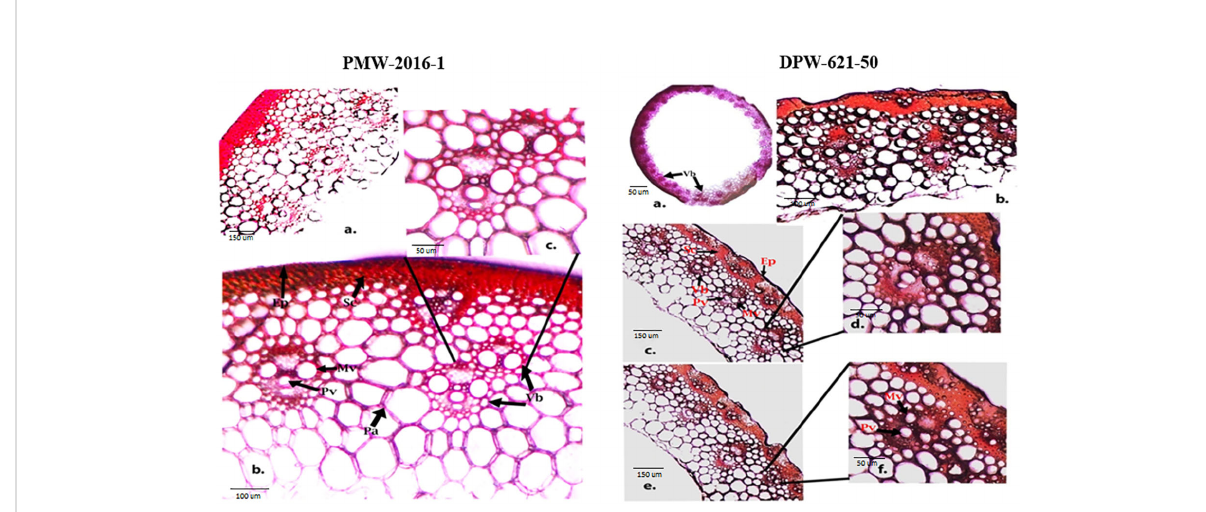
FIGURE 1 Phloroglucinal-HCl (Wiesner) staining of stem sections of PMW-2016-1 (A-C) and DPW-621-50 (A-F) showing lignin deposition in the walls of sclerenchyma, Protoxylem and Metaxylem cells. The positions of the Protoxylem (Pv), Metaxylem (Mv), Sclerenchyma (Sc), Parenchyma (Pa), Epidermis (Ep), Vascular bundles (Vb) are